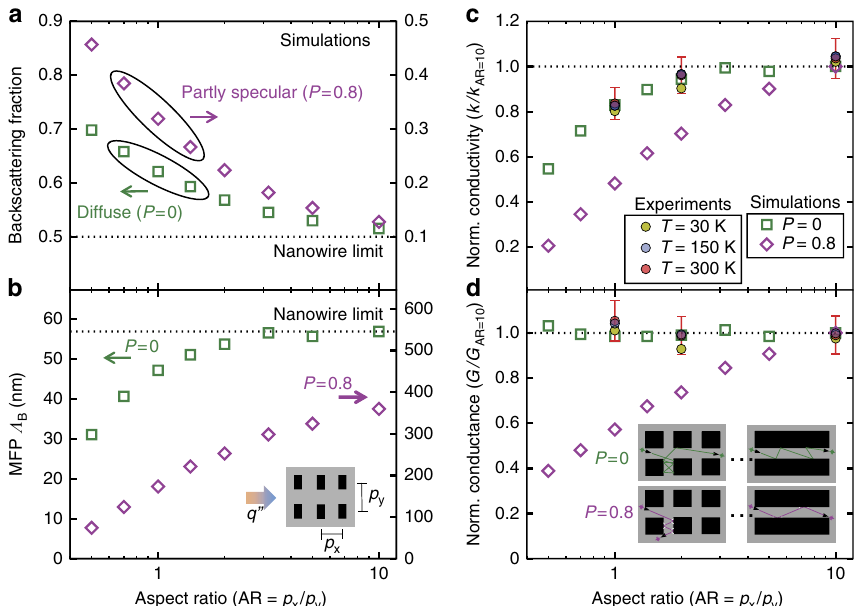
Figure 4 | Influence of backscattering. Ray tracing simulations investigate phonon backscattering for nanomesh structures with varying pitch aspect ratios AR ¼ p x / p y , comparing diffuse ( P ¼ 0) and partly specular ( P ¼ 0.8) surfaces. ( a ) Increasing the aspect ratio decreases the backscattering fraction, which quantifies the backscattering effect illustrated in Fig. 3c. For large aspect ratios, the backscattering fraction approaches the nanowire limit of (1 (cid:2) P )/2 (dashed line). ( b ) Consistent with the backscattering effect mechanism, the boundary scattering mean free path L B decreases as the backscattering increases. ( c ) Normalized conductivity k/k AR ¼ 10 from ray tracing simulations (empty points) and experiments at three different temperatures (filled points, taken from Fig. 3b) show decreasing k with increased backscattering (that is, with smaller AR). ( d ) The normalized conductance G/G AR ¼ 10 is surprisingly independent of aspect ratio for diffuse surfaces, which we attribute to a multiple backscattering effect (inset, green). If the surfaces are partially specular, the backscattering does reduce G . Panels c , d show that the experimental normalized conductivity and conductance results are consistent with diffuse scattering simulations. Error bars represent the experimental uncertainty derived using propagation of errors (for details see Supplementary Note